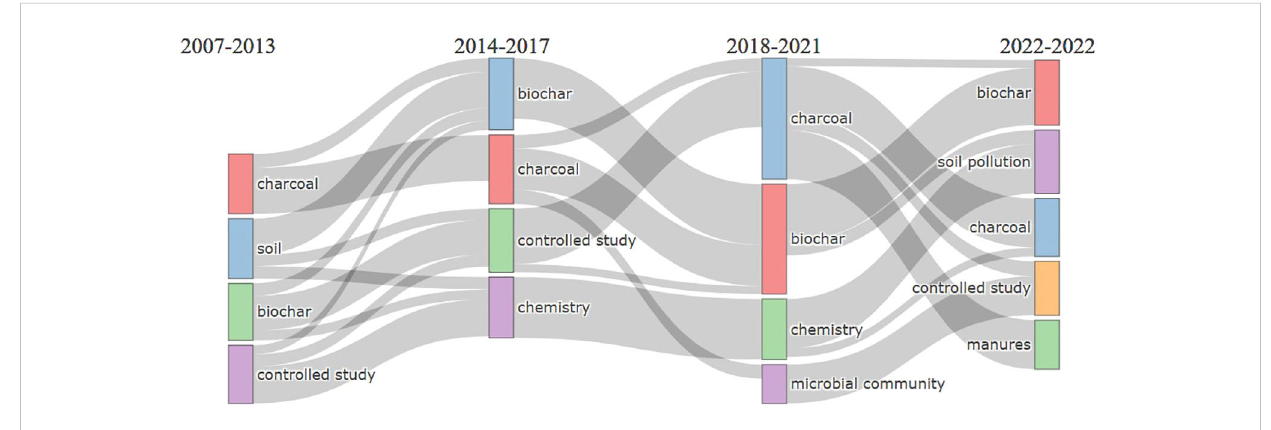
FIGURE 7 Thematic map evolution of index keywords from